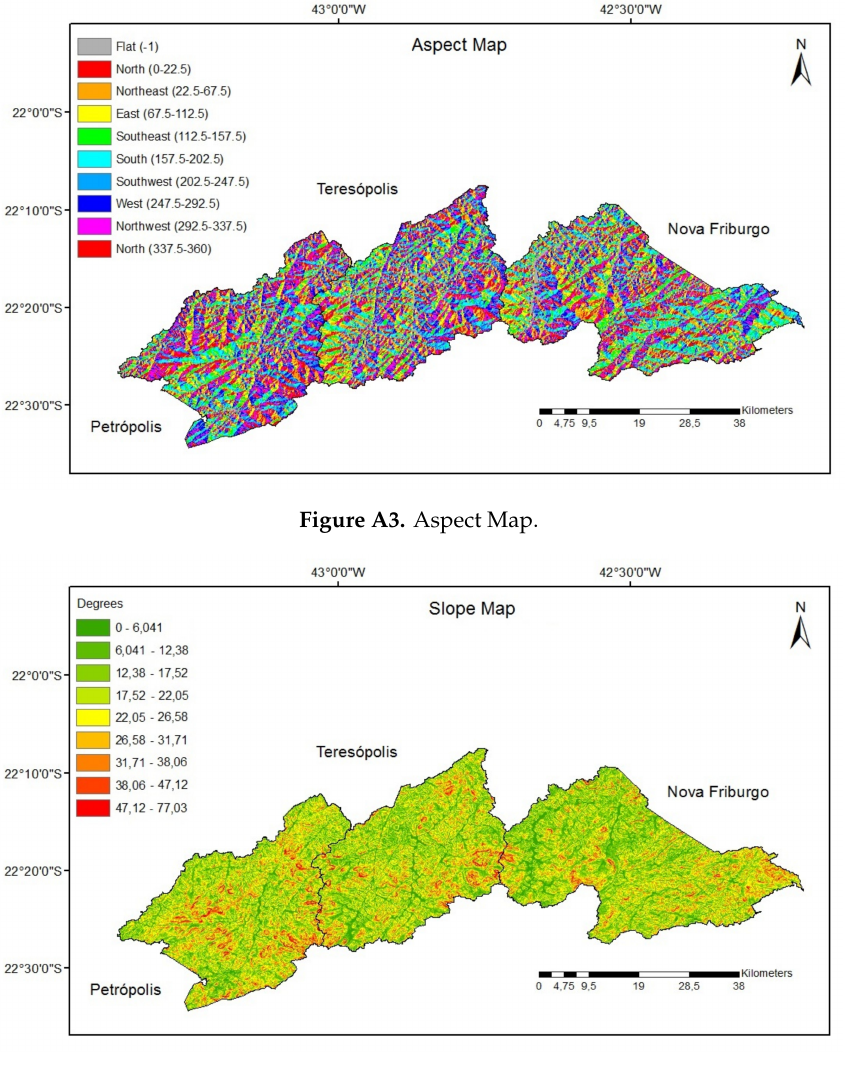
Figure A4. Slope